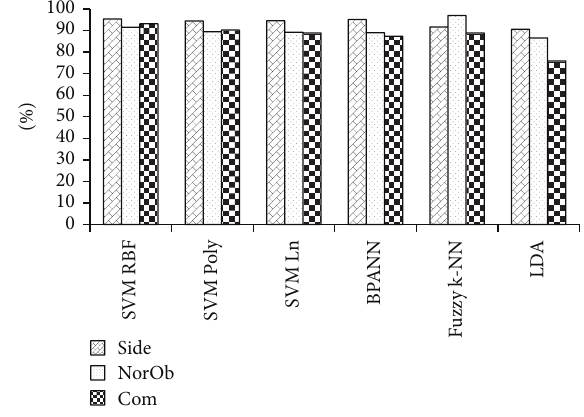
Figure 10: CCRs of MMUGait Large